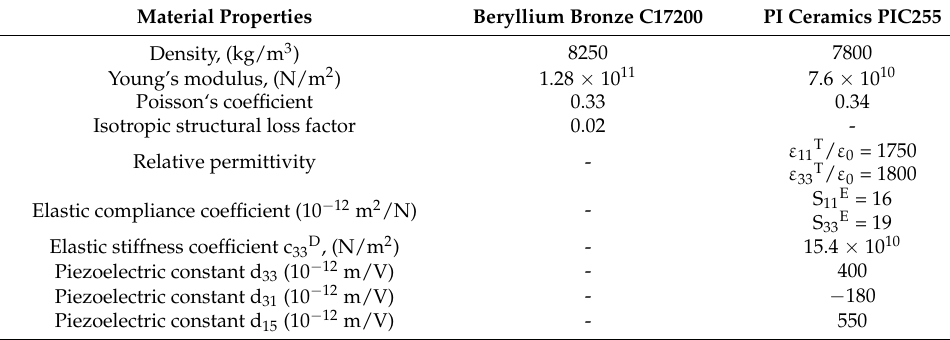
Table 2. Material characteristics.